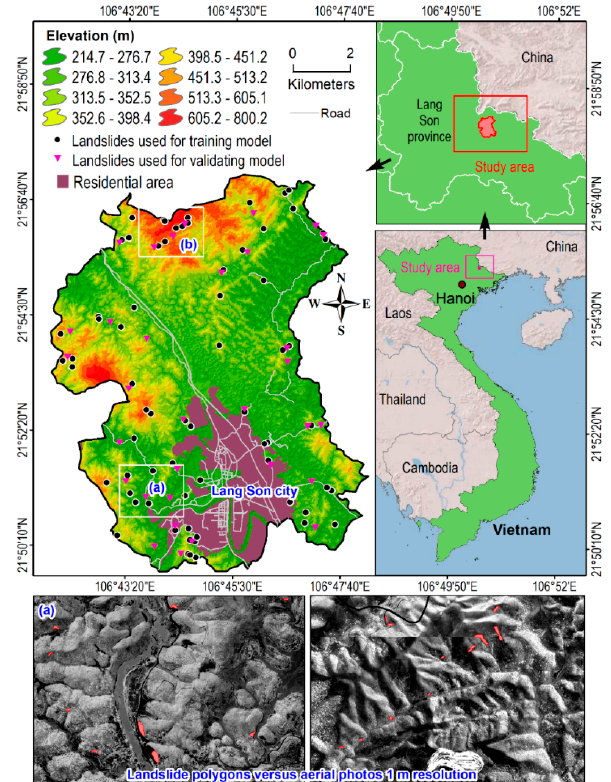
Figure 1. Location of the study area and landslide inventory.